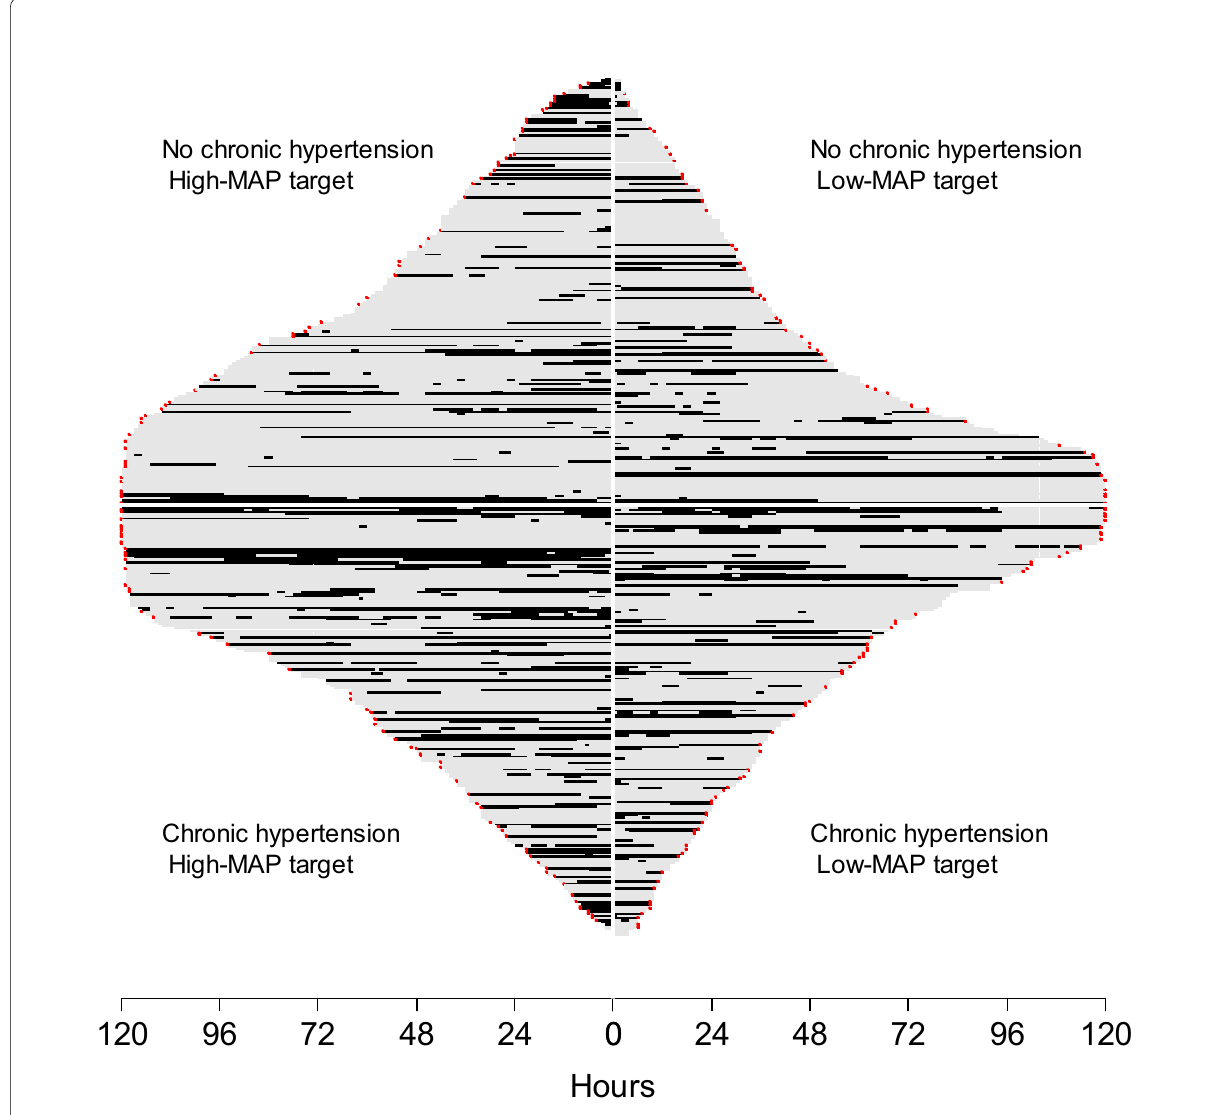
Fig. 3 Course of mottling in patients with septic shock, according to the mean arterial pressure (MAP) target and chronical arterial hypertension. Low‑MAP target group: 65–70 mmHg, High‑MAP target group: 80–85 mmHg. Each horizontal line represents a patient follow‑up. Solid line corresponds to a period of time with mottling; and hatched line corresponds to a period of time without mottling for the patient. A red asterisk at the end of a line represents the death of the patient. There was no difference in mottling time course according to the MAP target and chronic arterial